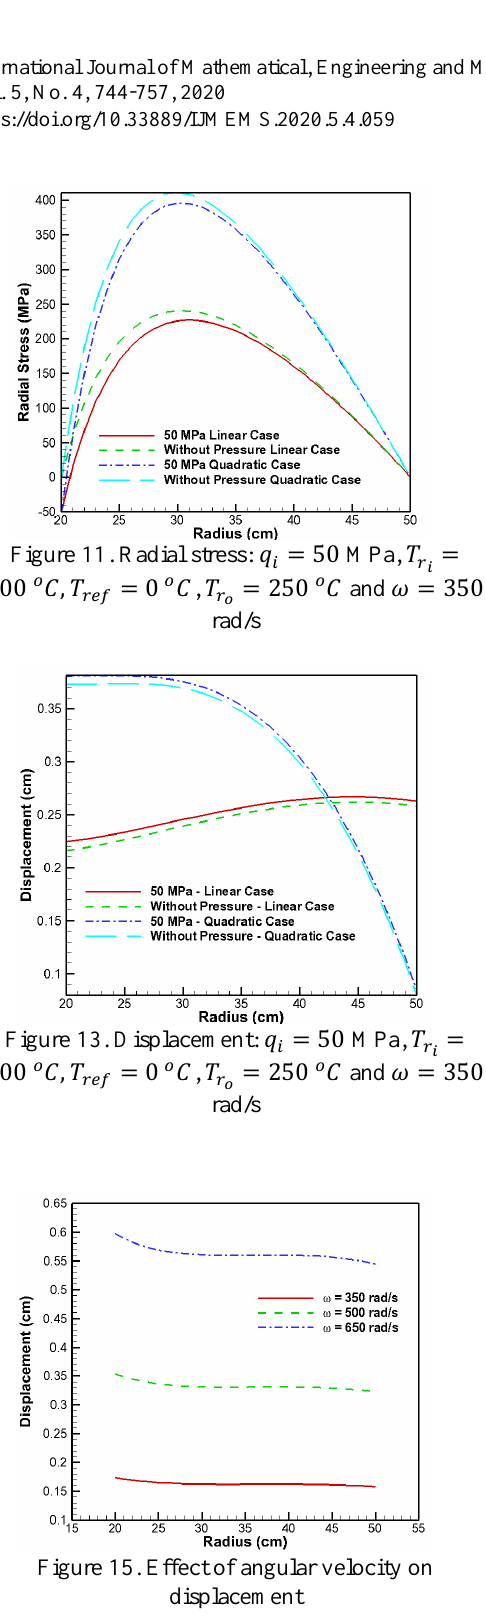
Figure 16. Effect of angular velocity on radial stress under 𝑞 = 50 𝑖